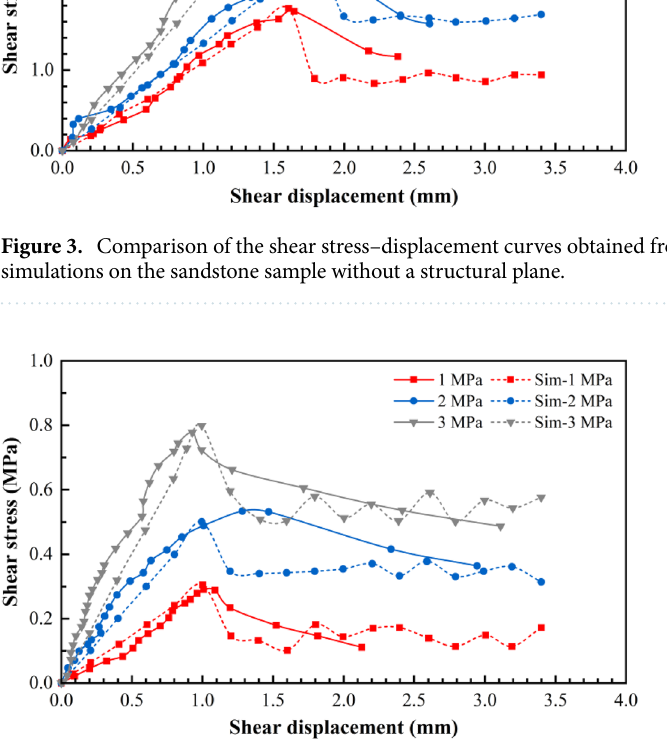
Figure 4. Shear stress–displacement curves obtained from the simulations of the flat structural plane in the sandstone sample.